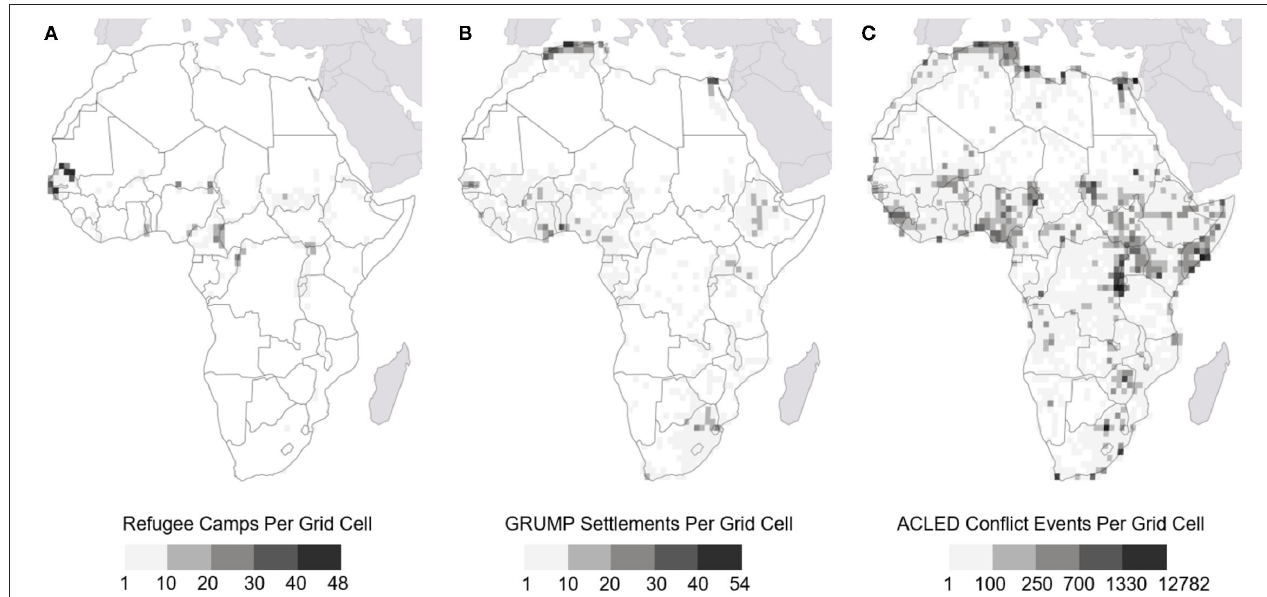
FIGURE 1 | Spatial distribution of (A) UNHCR refugee camps, (B) GRUMP settlements, and (C) ACLED conflict events per square decimal degree grid cell. Camps, settlements, and conflict events are aggregated here for purposes of visualization.